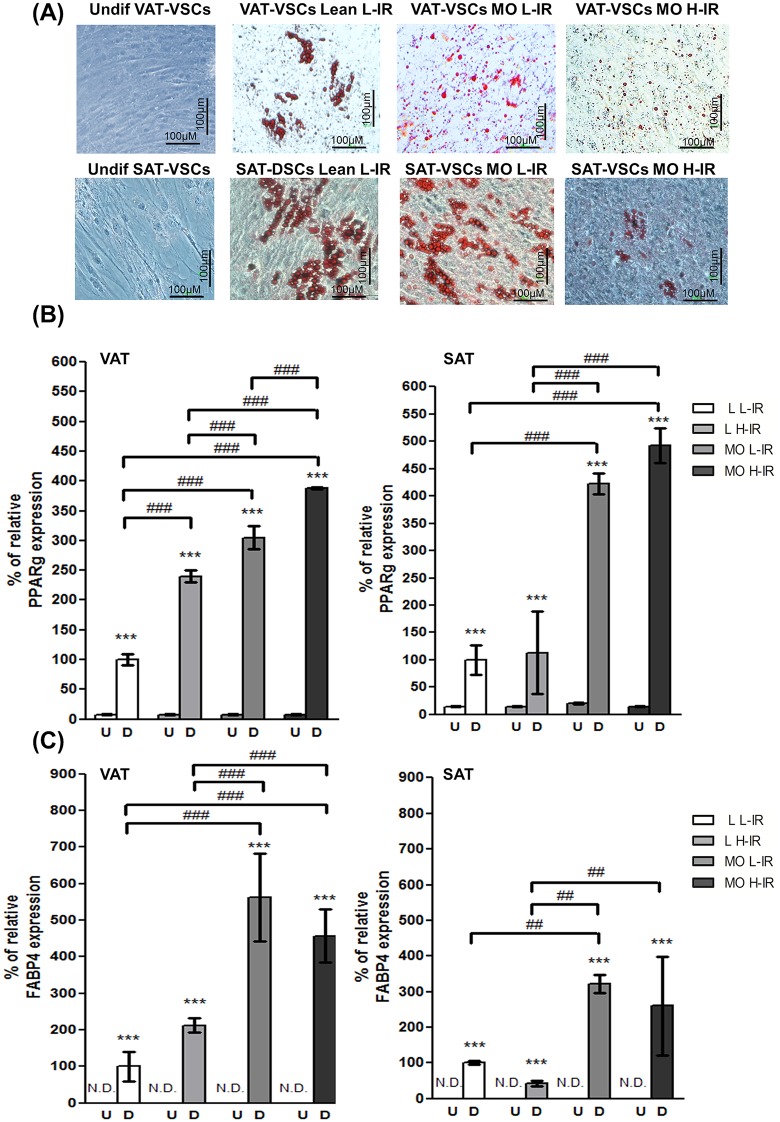
Adipogenic differentiation of hVSCs from VAT and SAT of subjects with different BMI and HOMA-IR index.A) Representative photomicrographs of undifferentiated VAT-derived stromal cells (VAT-VSCs) and SAT-derived stromal cells (SAT-VSCs) (left column) and differentiated adipocytes from VAT-VSCs (upper row) and SAT-VSCs (lower row) stained with the lipophilic marker oil red O. The images show brown spots in samples from all groups, corresponding to lipid accumulation within the newly generated adipocytes. Due to a technical problem, images from Lean H-IR samples are not available. They were instead analyzed by RT-PCR. (B and C) mRNA expression of the adipocyte marker PPARγ2 (B) and FABP4 (C) in undifferentiated and differentiated samples corresponding to VAT (left column) and SAT (right column) from all groups. Gene expression was referred to differentiated lean-Low-IR samples, which were considered as 100%; RPL13A was used as reference gene. Data represent mean ± SEM of four samples in each bar. FABP4 expression in undifferentiated samples could not be detected in our assay (N.D.). Both PPARγ2 and FABP4 expression were dramatically increased in samples from differentiated cells, being higher in samples from morbid obese when compared to lean subjects, independently of the associated insulin resistance condition, (MO L-IR or MO H-IR versus Lean L-IR or Lean H-IR). Additionally, PPARγ2 levels in VAT were different in each group when compared to any other, with expression levels decreasing in the following way, MO H-IR>MO L-IR>Lean H-IR>Lean L-IR (Two-way ANOVA and Bonferroni post-hoc test. Asterisks represent comparisons between undifferentiated and differentiated samples within each study group; hashes represent comparisons among differentiated samples from different study groups). VAT: visceral adipose tissue; SAT: subcutaneous adipose tissue; VAT-VSCs: stromal cells derived from visceral adipose tissue; SAT-VSCs: stromal cells derived from subcutaneous adipose tissue; Lean L-IR: lean subjects with low-degree insulin resistance; Lean H-IR: lean subjects with high-degree insulin resistance; MO L-IR: morbid obese subjects with low-degree insulin resistance; MO H-IR: morbid obese with high-degree insulin resistance.